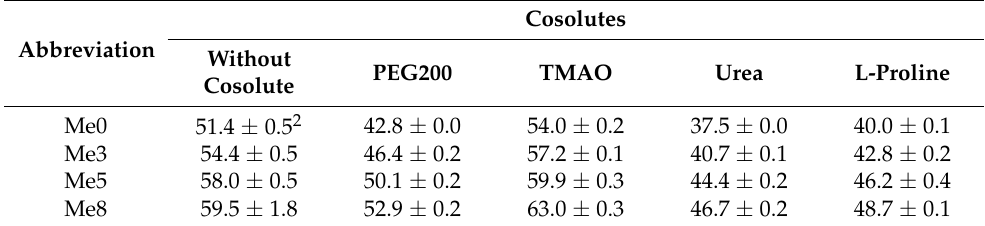
Table 1. Melting temperature ( T m ) 1 ( ◦ C) for 2.0 µ M oligonucleotides in the absence or presence